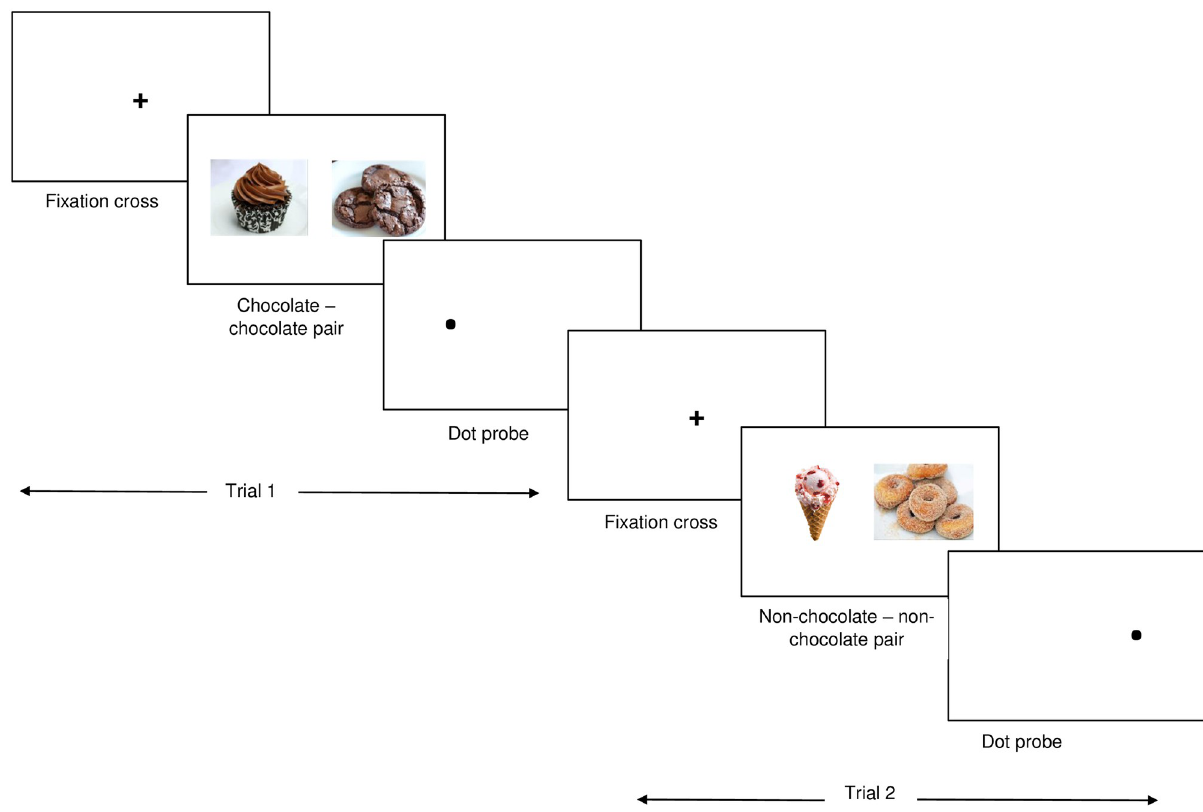
Fig 1. Schematic presentation of sham-n